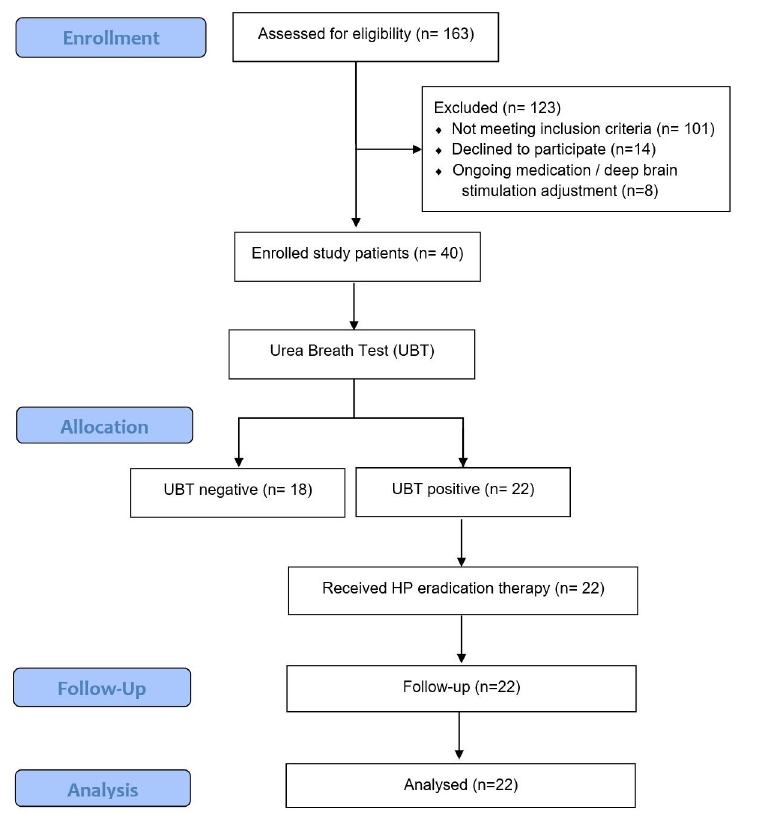
Fig 1. Flow diagram of patient selection